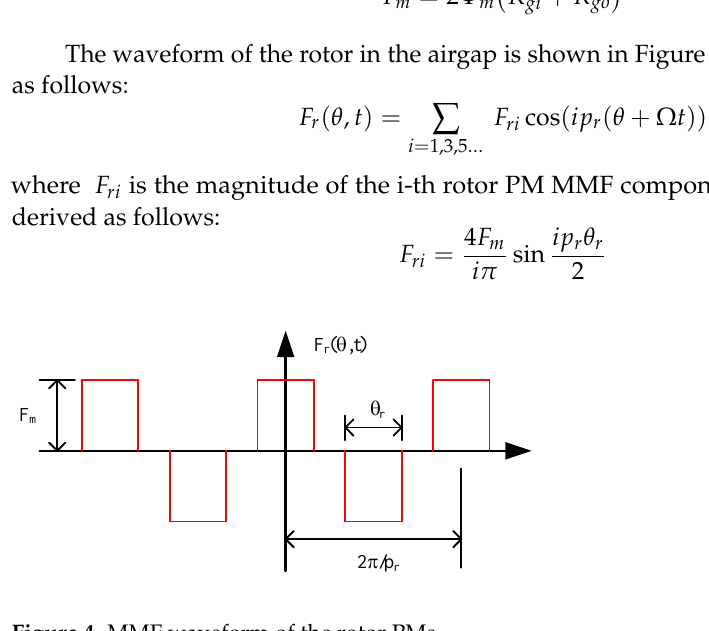
Figure 4. MMF waveform of the rotor PMs.